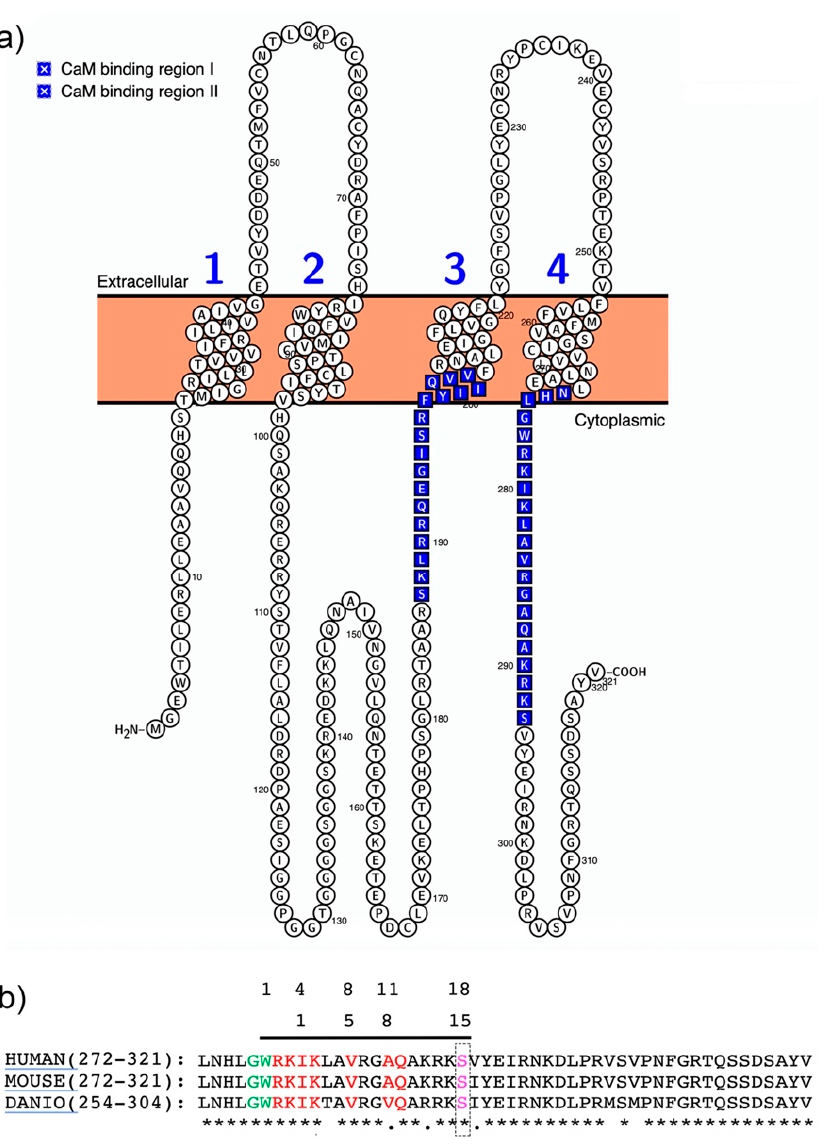
Figure 2. Structure of the Cx36–CaM -binding motifs. ( a ) Visualization of the predicted murine Cx36 structure using Protter software [73]. The CaM -binding regions I and II are indicated in blue. ( b ) Protein sequence alignment of the carboxyterminal domains of mammalian and zebrafish ( Cx35b ). The sequence homology and the two overlapping CaM -binding motifs described by [54,64] are highlighted in light green and red. The PKA phosphorylation site in position S293 (pink) is located at the boundary of the core CaM- binding motif